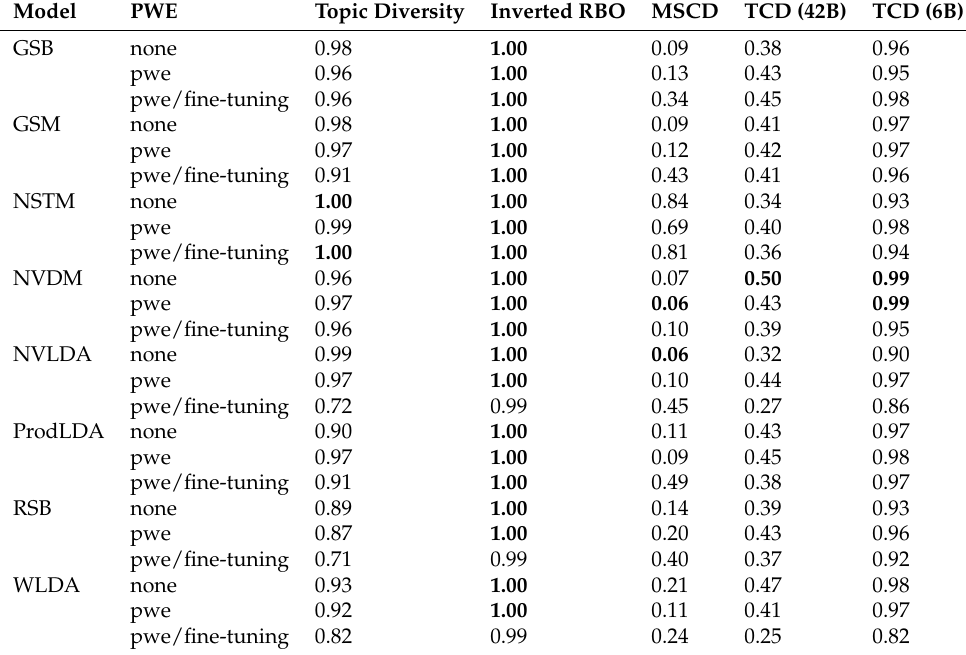
Table 17. Topic Diversity on